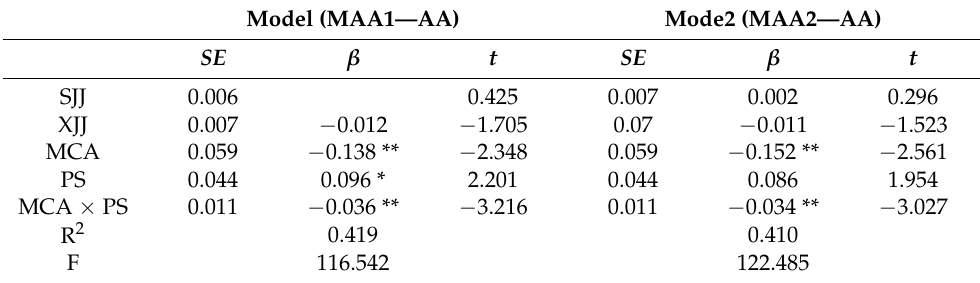
Table 4. Test of the moderating effect of peer support (N =